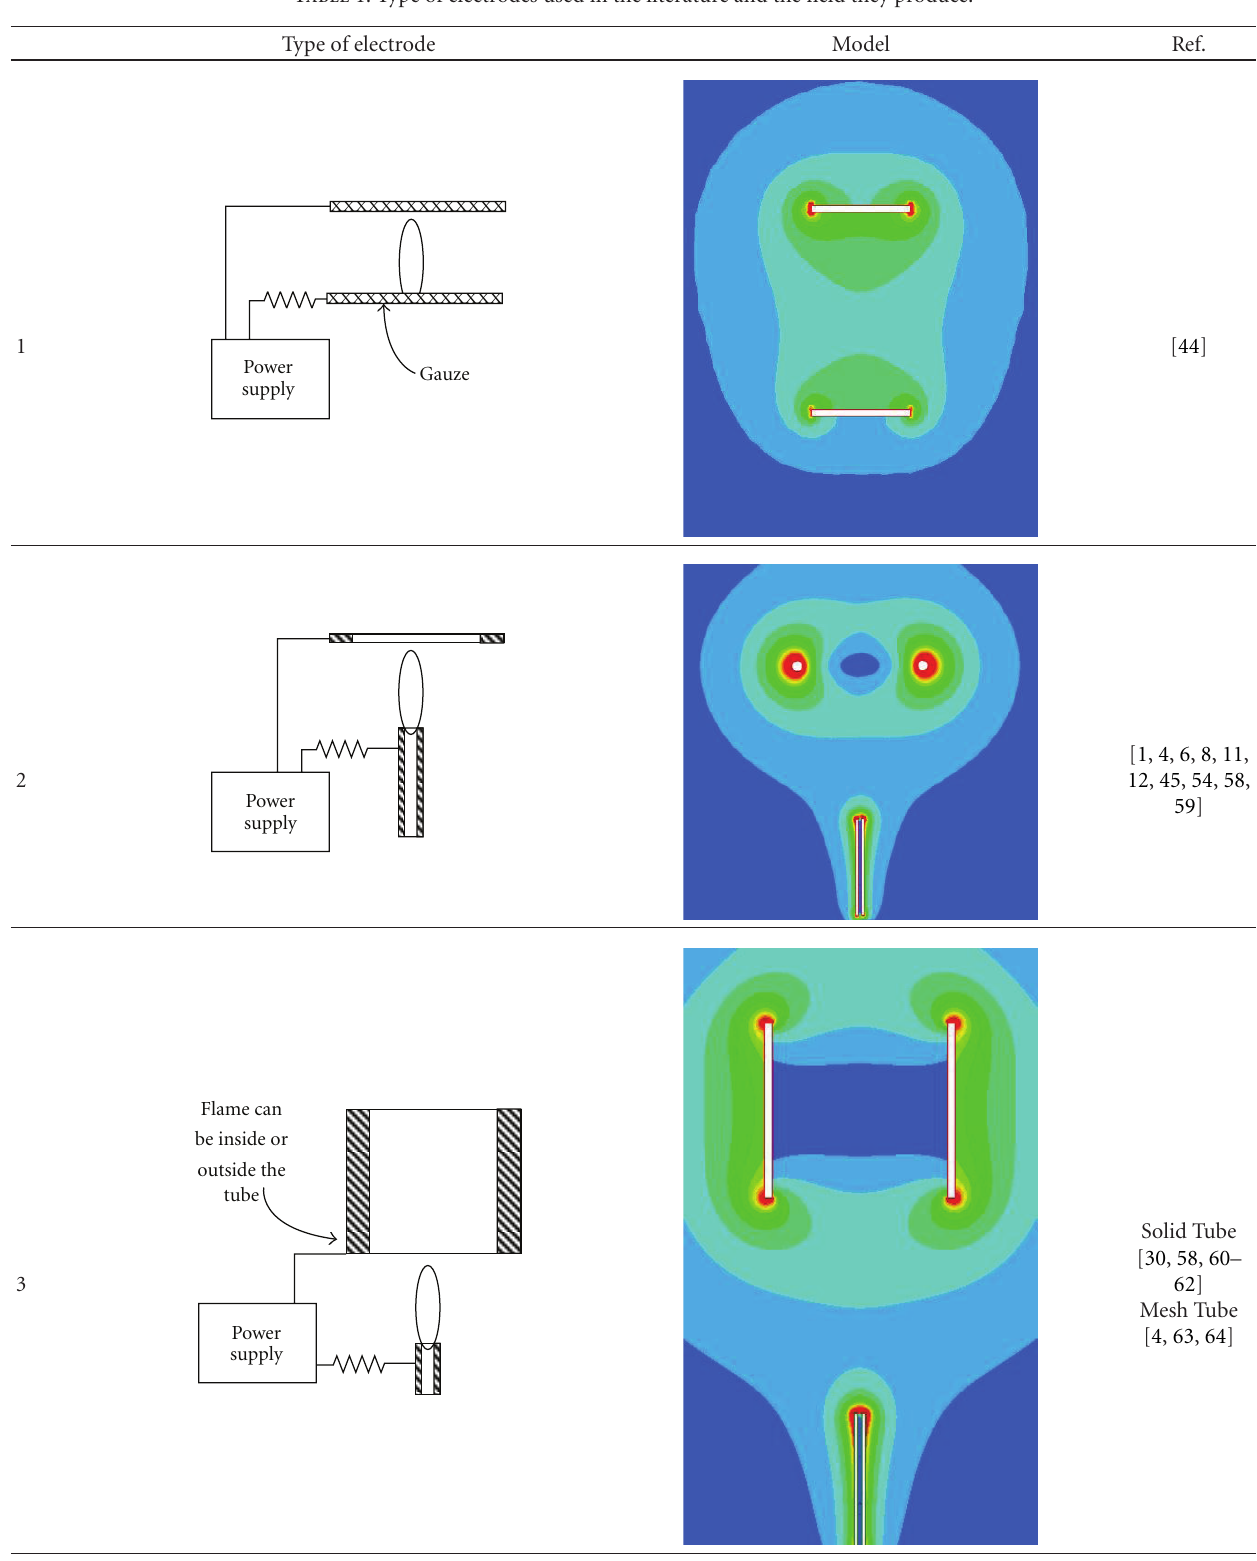
Table 1: Type of electrodes used in the literature and the field they